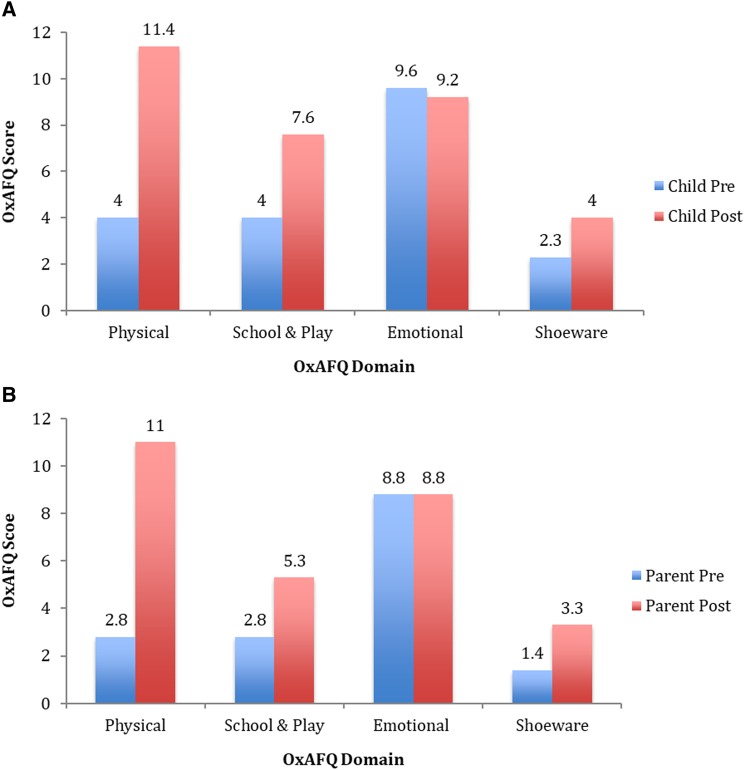
Domain scores shown pre-surgery and at 12 months post-frame removal(A) Oxford Ankle Foot Questionnaire-Child (OxAFQ-C). (B) Oxford Ankle Foot Questionnaire-Parent (OxAFQ-P).